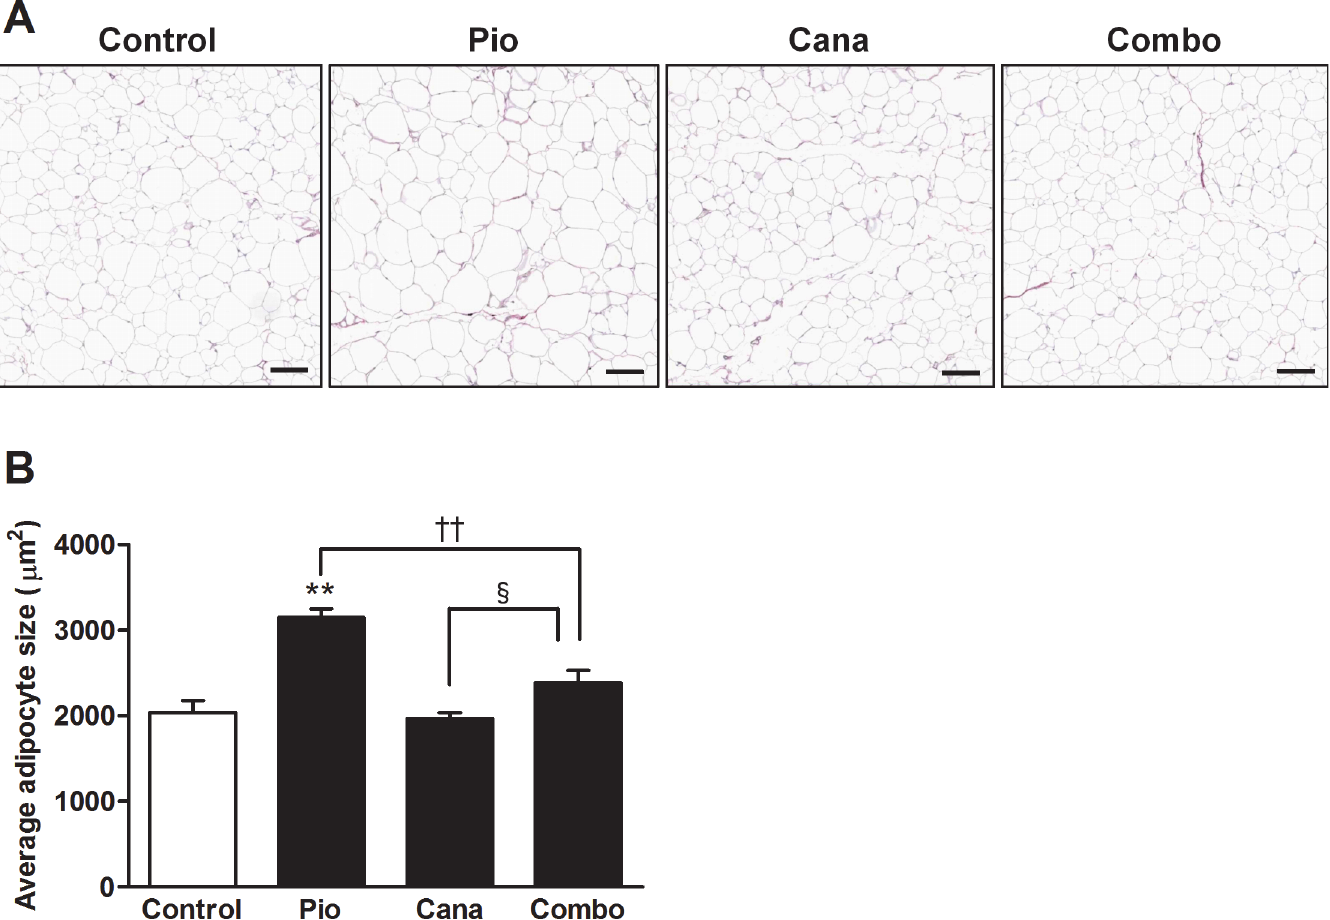
Figure 4. Histological analysis of adipose tissue in KK-A y mice. A: Representative images of mesenteric adipose tissue and B: Average size of adipocytes. Canagliflozin (Cana; 0.01% w/w food admixture), pioglitazone (Pio; 0.01% w/w food admixture), and their combination (Combo) were administered for 2 weeks. Mesenteric adipose tissue was stained with elastic van Gieson without nuclear staining at the end of the study. The size of 500 adipocytes was analyzed using Image-Pro Plus software. Data are expressed as mean ± SEM (n = 8). ** P < 0.01 vs. control, †† P < 0.01 vs. Pio, § P < 0.05 vs. Cana. Scale bar = 100 μ